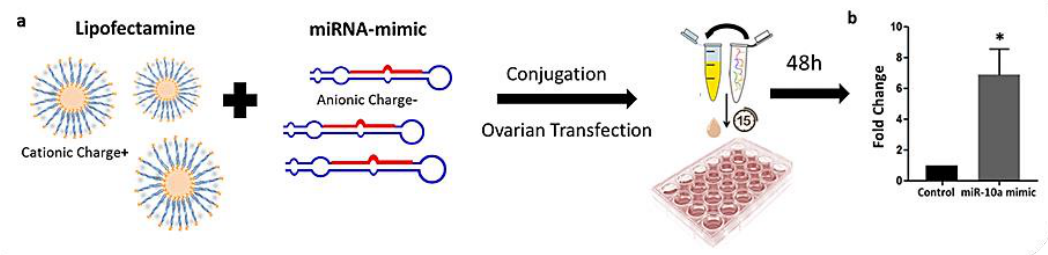
Figure 2. Liposome-based miR-10a mimic delivery in PND3 ovaries in vitro. ( a ) Diagrammatic representation of study’s workflow and findings. The application of miRNA replacement approaches using liposomes and miR-10a mimic molecules that could successfully increase the levels of miR-10a in PND3 ovaries in vitro. ( b ) Fold change of miR-10a expression levels of miR-10a after 48 h of transfection with miR-10a mimic using a liposome-delivery system compared to non-transfected (control) ( n = 3). * p -value < 0.05. The error bars represent the standard error.